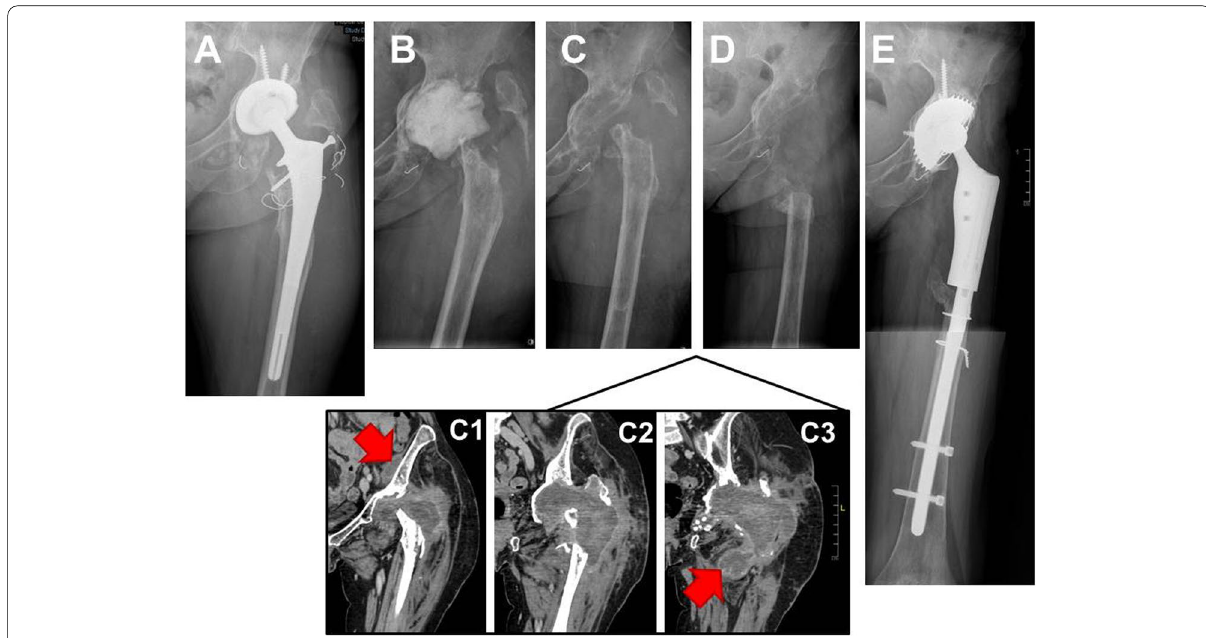
Fig. 1 X-ray and CT-scan of the left hip performed: A at admission; B after prosthesis explantation, debridement and set-up of a spacer; C after performance of a new debridement and spacer removal, unfortunately with recurring abscesses visible on CT-scan (C1: ilio-psoas recurrent abscess, red arrow; C2: large collection within the joint; C3: abscesses in the thigh, red arrow) despite prolonged hydroxychloroquine-doxycycline treatment; D after a subsequent surgery with debridement of the recurrent abscesses and performance of a femoral resection; E 6 years after reimplantation of a megaprosthesis, no prosthesis